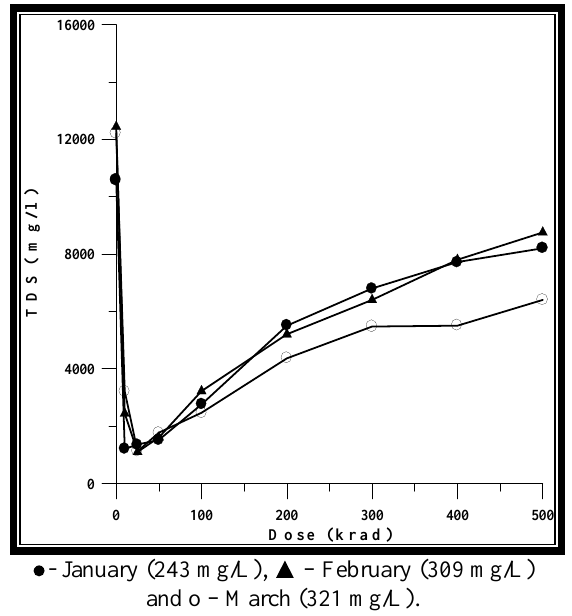
Figure 9: TDS values of irradiated sample of wastewater for BOD . 5